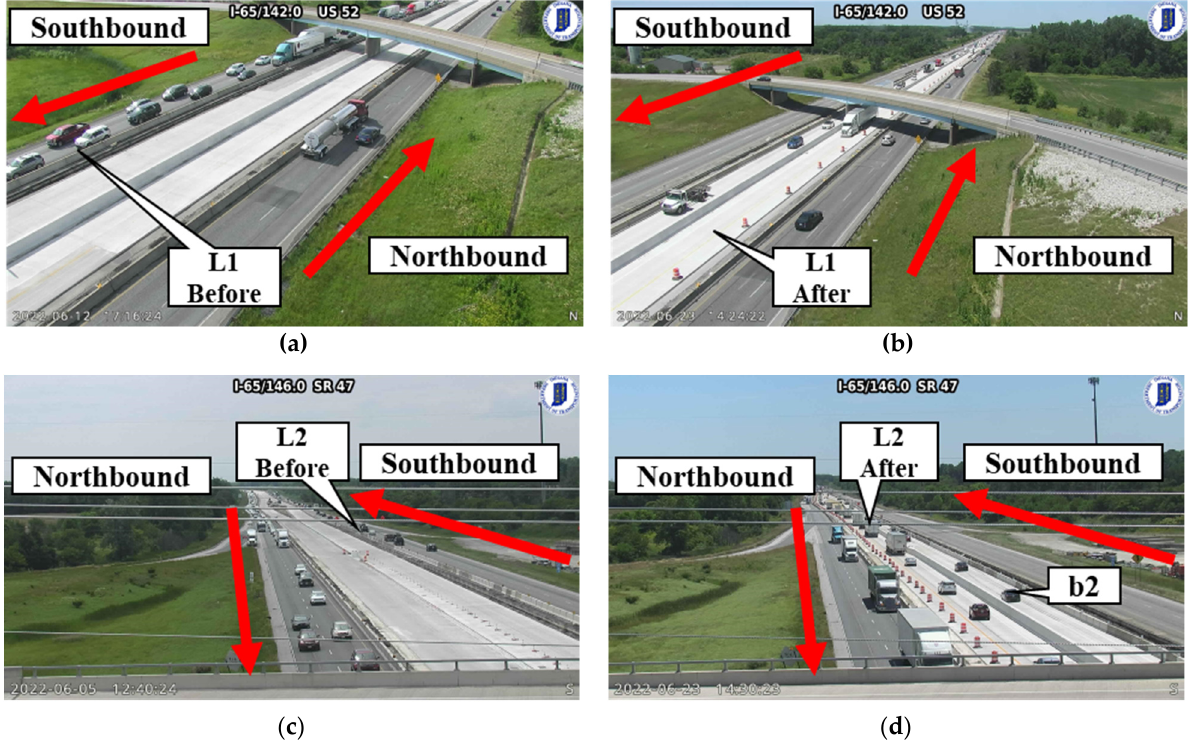
Figure 13. I-65 traffic cameras for roughness validation: ( a ) reference marker 142.0 before 20 June 2022; ( b ) reference marker 142.0 after 20 June 2022; ( c ) reference marker 146.0 before 20 June 2022; ( d ) reference marker 146.0 after 20 June 2022.